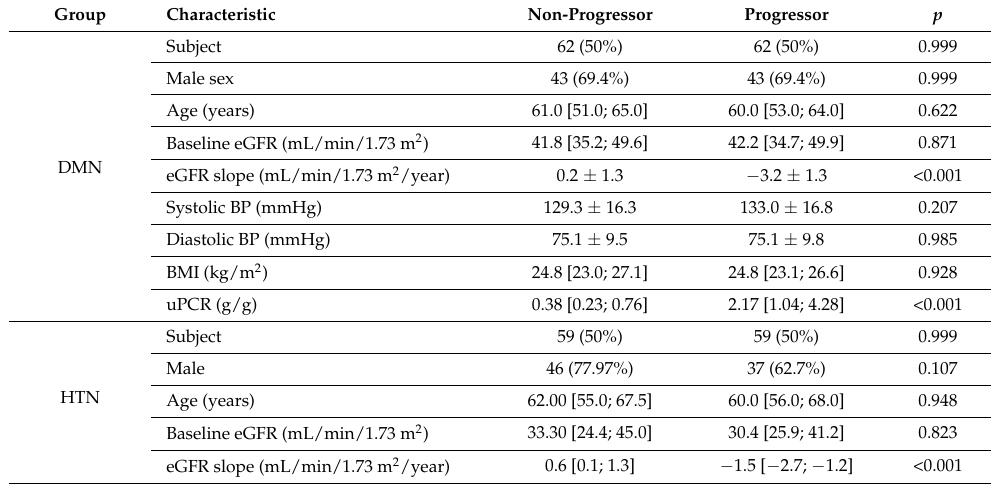
Figure 1. Schematic description of this study. Clinical data and serum samples from three chronic kidney disease cohorts, namely diabetic nephropathy (DMN, n = 124), hypertensive nephropathy (HTN, n = 118), and polycystic kidney disease (PKD, n = 124), were collected. In each disease group, half of the patients with lower eGFR slope were defined as disease-progressors, while the others were defined as non-progressors. Other clinical parameters including age, sex, and baseline eGFR, were confirmed to have no significant differences between progressors and non-progressors. Targeted metabolomics was performed to quantify 188 metabolites in the baseline serum samples of all the cohorts. For each group, disease progression-related metabolite biomarkers were selected based on statistical analysis. Finally, predictive models were generated and validated through 5-fold cross-validation. Images were created with BioRender.com. Table 1. Baseline characteristics of enrolled patients according to the cause of chronic kidney disease.